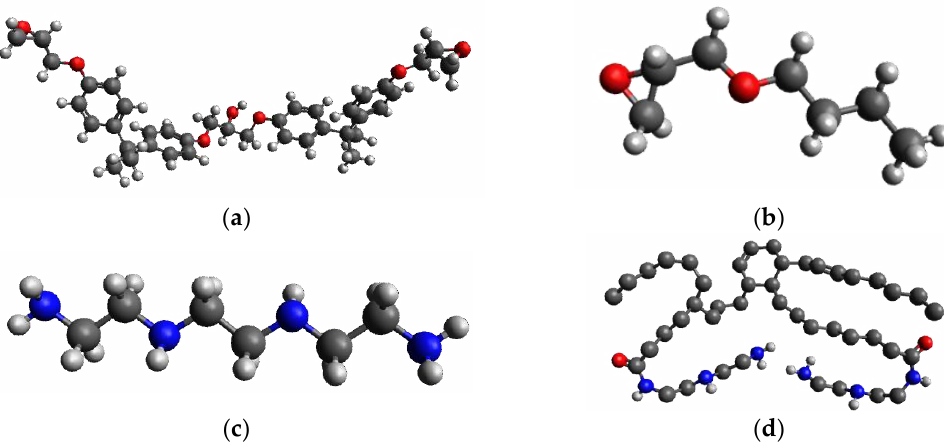
Figure 1. United atom depiction of the modeled EPON 815C/Epikure 3140 epoxy resin consisting of ( a ) DGEBA, ( b ) BGE, ( c ) TETA, and ( d ) dimerized fatty acid. Nonpolar hydrogens are implicitly included in the bonded carbon atom in the united atom model.